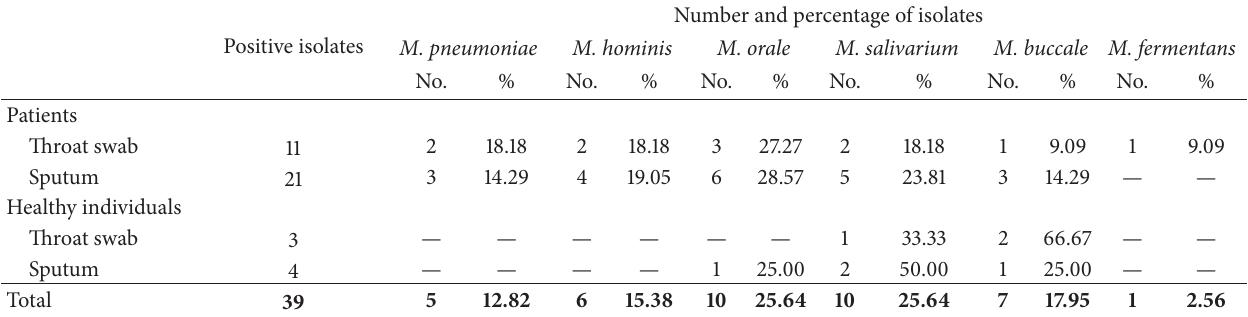
Table 2: The number and percentages of each Mycoplasma species isolated from all specimens and samples. Number and percentage of Positive isolates